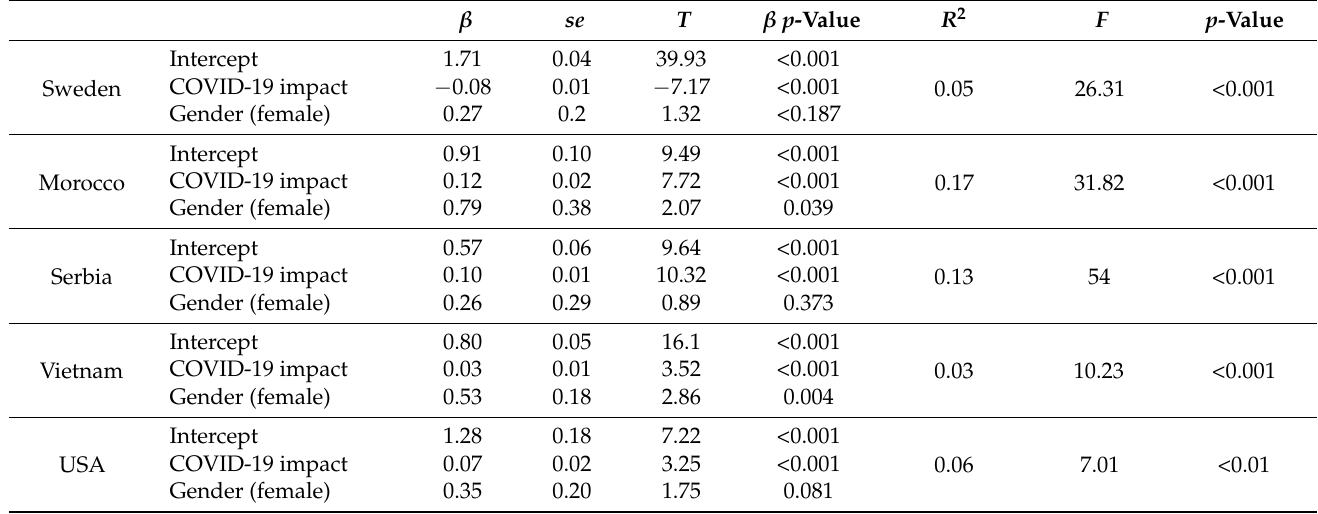
Table 6. Predicting Global Severity Index from the COVID-19 impact score and gender.